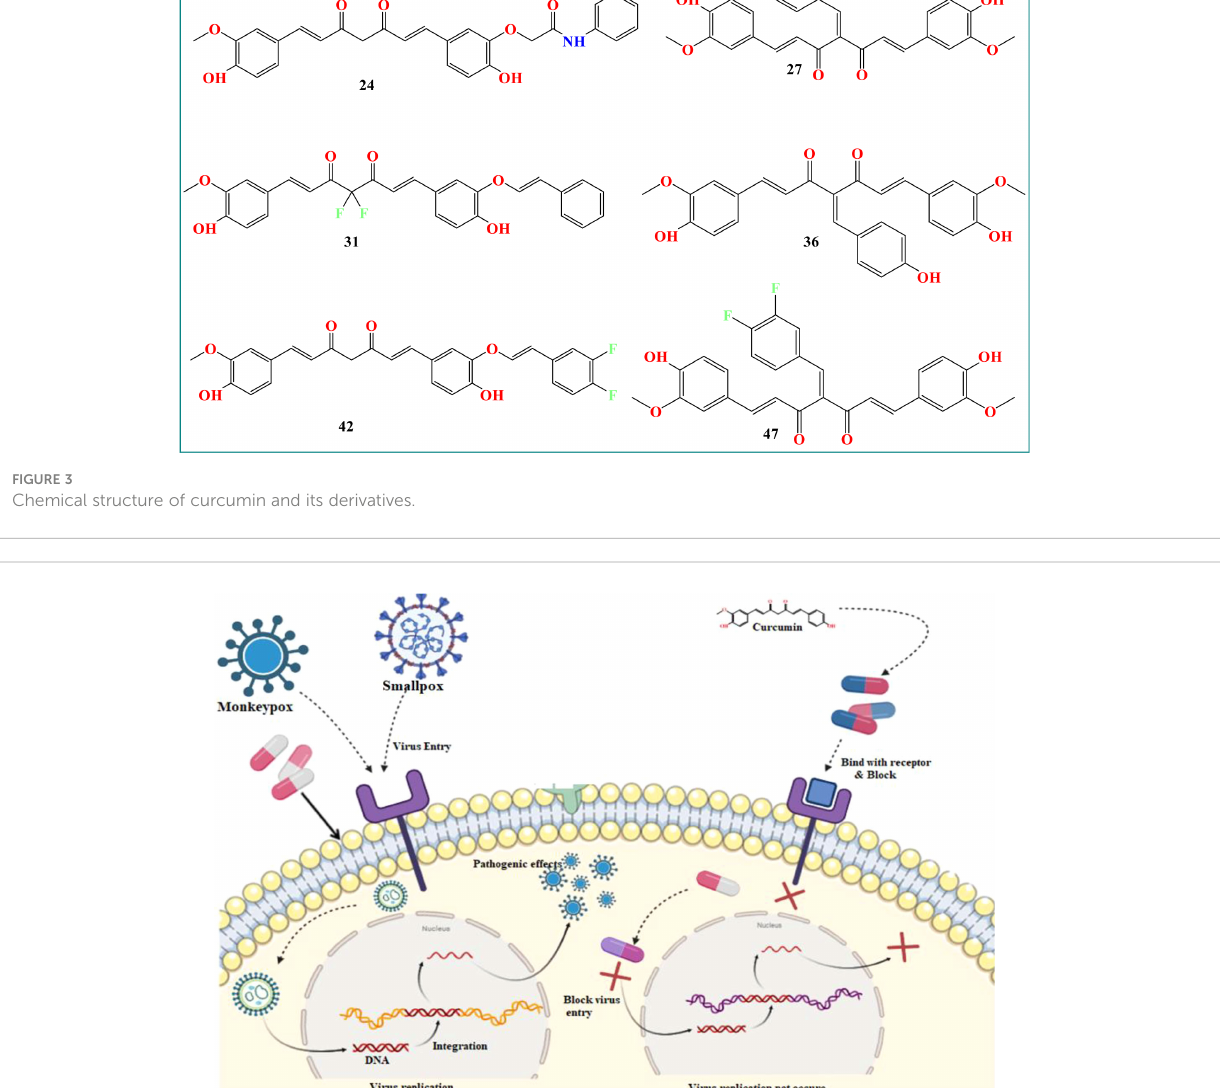
FIGURE 4 Probable mechanism action of curcumin against the virus.